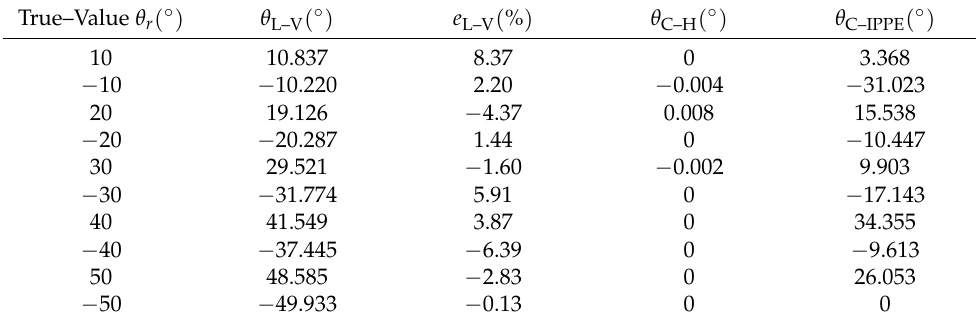
Table 2. Measurement results of rotation angle θ about the Y C axis.